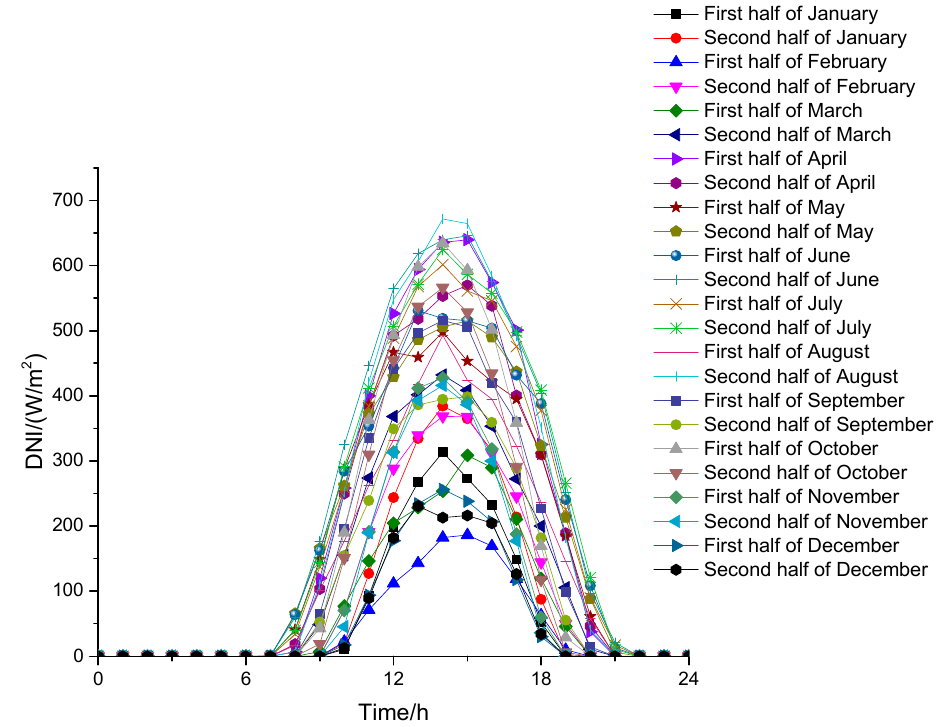
Figure 14. The changes of average ambient temperature every half a month of the year.